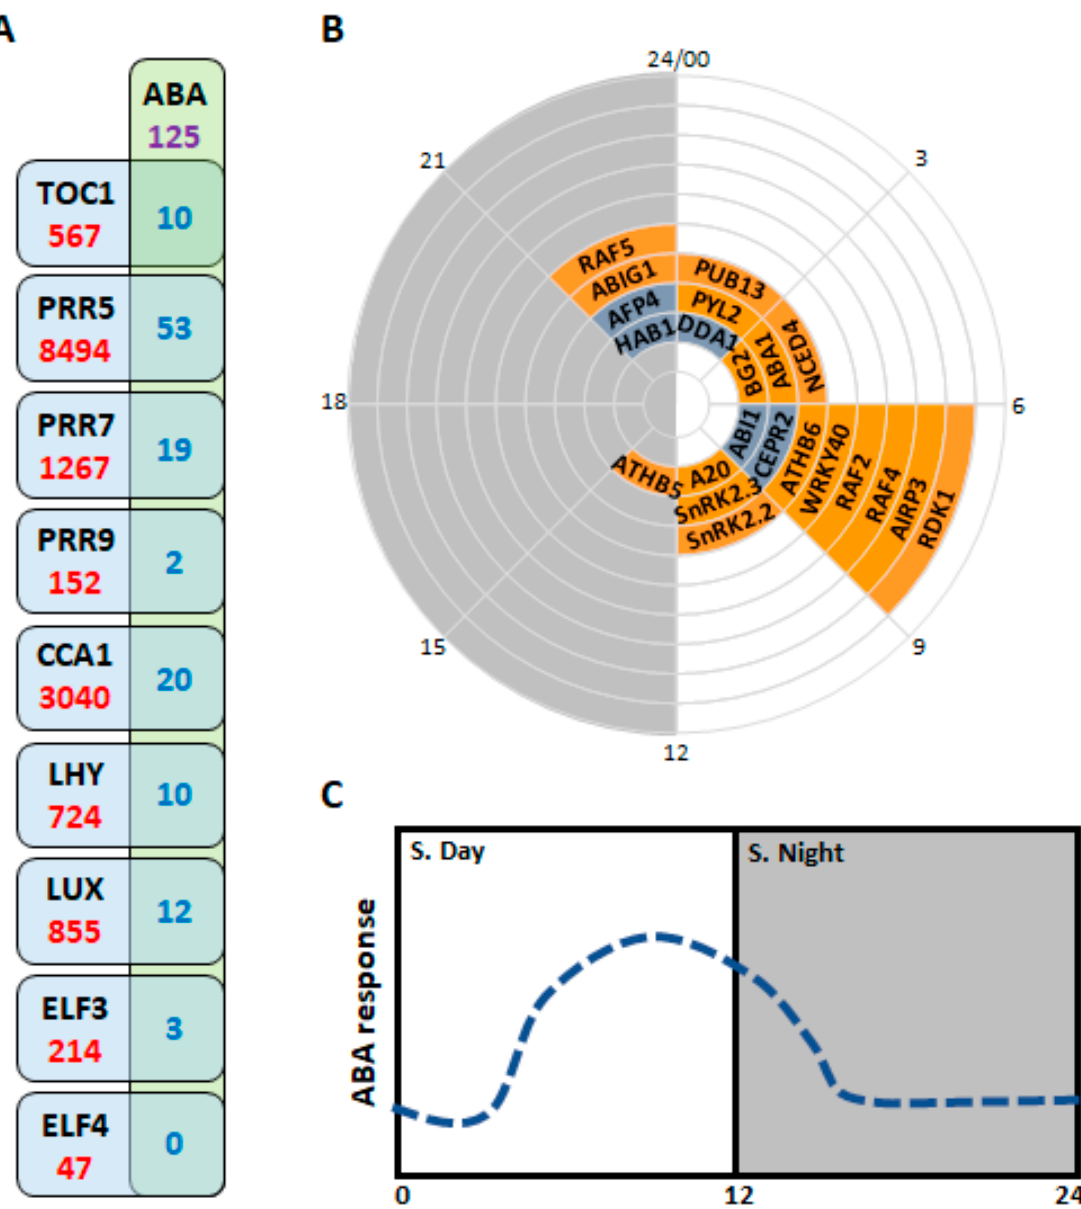
Figure 3. Connections between Circadian Clock and ABA machinery. ( A ) Circadian clock components interact with the promoter of different ABA machinery genes. Data extracted from RNAseq experiments found in literature from A. thaliana . In purple: ABA machinery components analyzed in this review (for more information see Table S1); in blue: number of ABA machinery genes regulated by each circadian transcription factor; in red: number of genes potentially regulated by each transcription factor. ( B ) Phase plot or wind-rose of gene expression time of ABA machinery components. Components with circadian oscillation only plotted. The name of each component appears in the graph at the time of acrophase (maximum of gene expression). Expression data was extracted from DIURNAL web (http://diurnal.mocklerlab.org/, accessed on 21 December 2021) and obtained from plants ( A. thaliana ) under constant light conditions (free running). White background, from 0 to 12 h, represents the circadian subjective day, and grey background, from 12 to 24 h, the circadian subjective night. ( C ) Putative circadian regulated ABA response gating in plants. S. Day: circadian subjective day; S. night: circadian subjective night. 0, 12 and 24: circadian